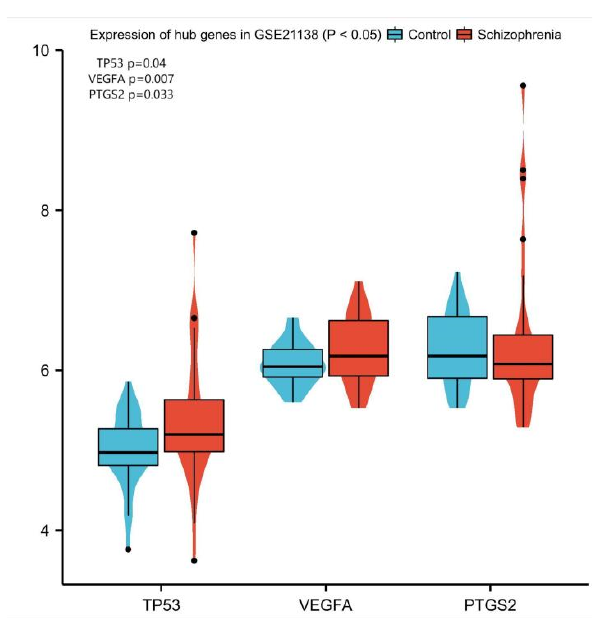
Figure 7. Expression of TP53, VEGFA and PTGS2 in brain tissue ( P < 0.05).